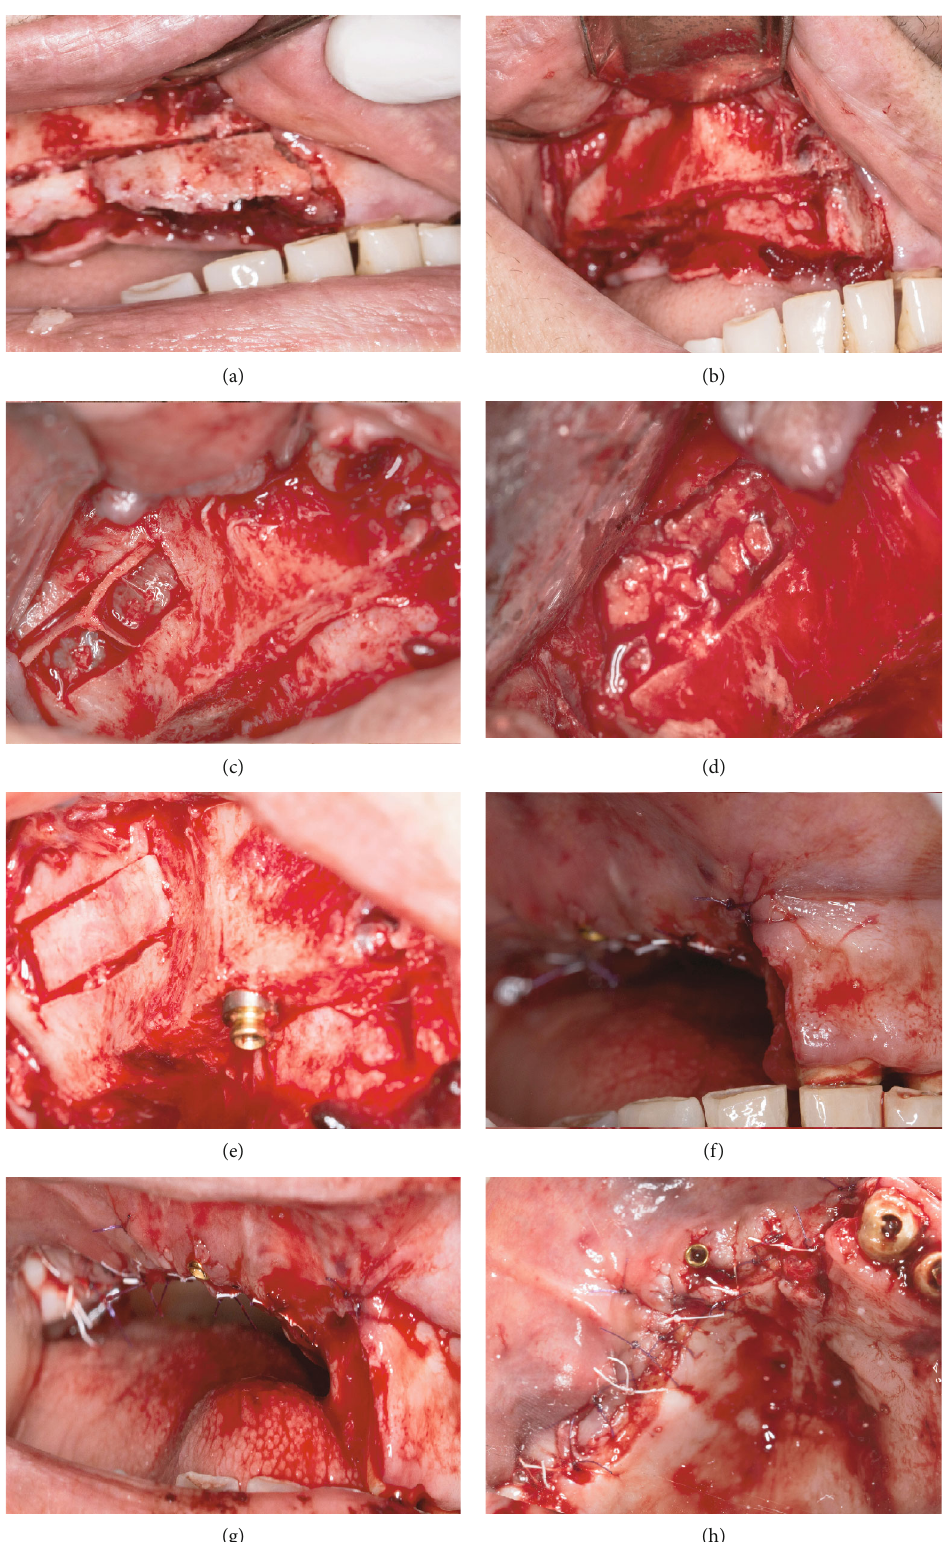
Figure 2: Left hemimaxilla: (a, b) segmental osteotomy of the alveolar process. (c) Lateral window approach during left maxillary sinus fl oor elevation. (d) Crushed resected alveolar process grafted inside the sinus. (e) Picture showing lateral bony window placed back and implant inserted in the canine region. (f – h) Respectively: frontal, lateral, and occlusal view of the postoperative clinical situation immediately after